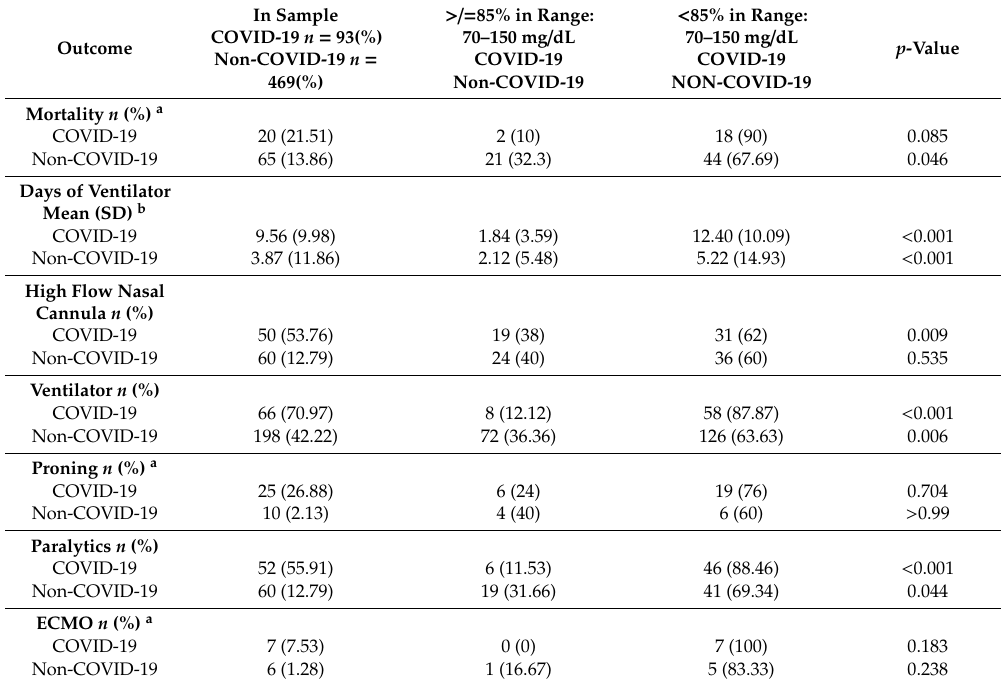
Table 3. Respiratory support and outcome compared with glycemic control ( n =